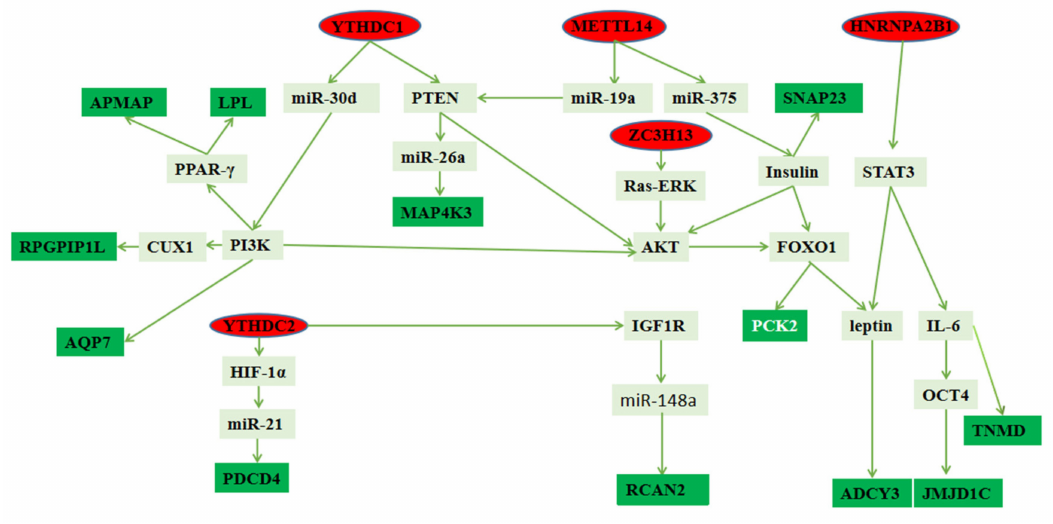
Figure 7. Pathway map of key genes regulated by